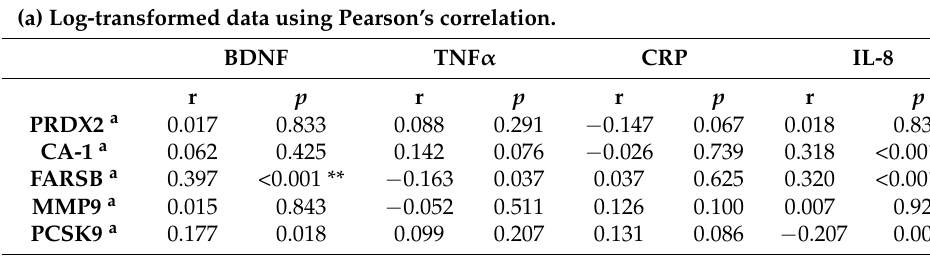
(b) Original data using Spearman’s correlation.